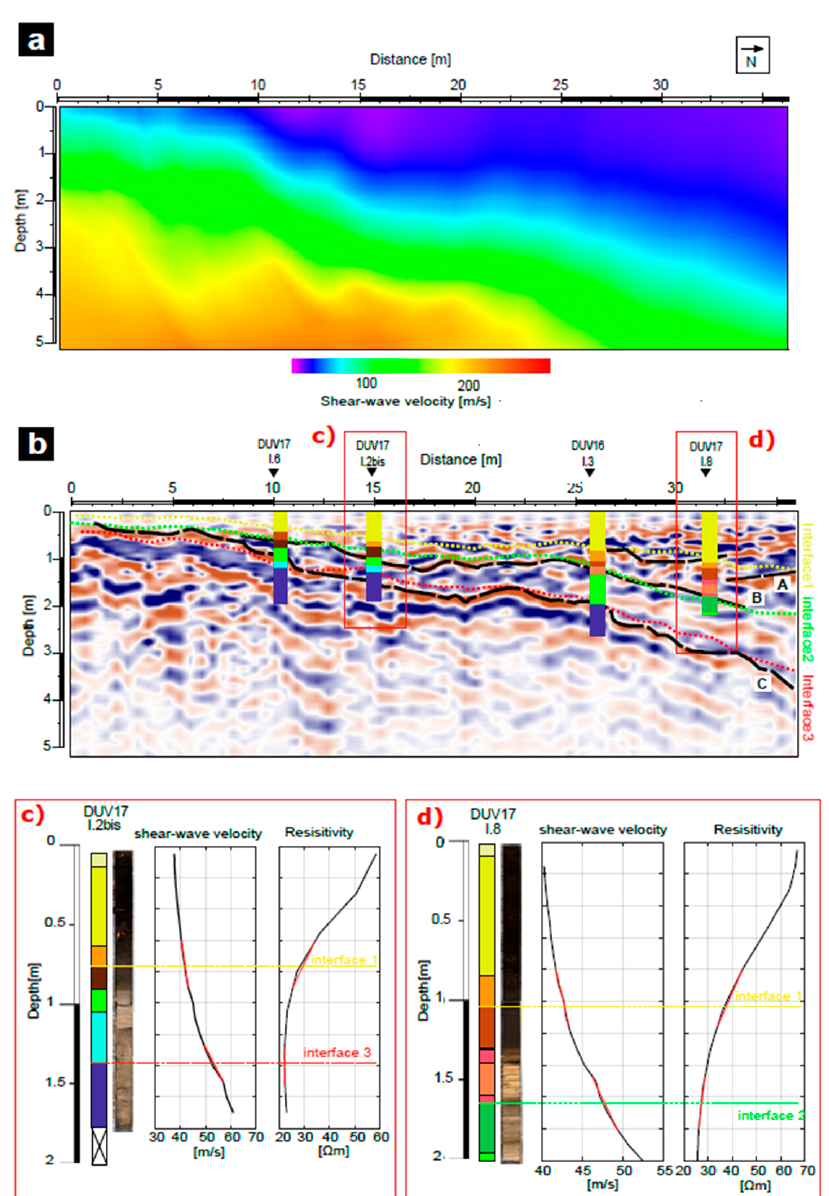
Figure 7. Shear-wave tomography and the reflection seismic section of the measured profile. ( a ) Color-coded shear-wave velocities tomography. ( b )Time-migrated and depth-converted reflection seismic, together with stratigraphy, GPR interfaces and their interpretation. The GPR interfaces are color coded (Interface1, Interface2 and Interface3). The main reflectors from the seismic reflection profile associated with GPR interfaces are marked with black lines (A,B,C). For the legend, see Figure 6. ( c ) Comparison between the shear-waves velocity depth curve and resistivity depth curve at the location of core I.2bis. The interfaces from GPR are indicated with dashed lines (yellow and red). ( d ) Comparison between the shear-waves velocity depth curve and resistivity depth curve at the location of core I.8. The interfaces from GPR are indicated with dashed lines (yellow and green).